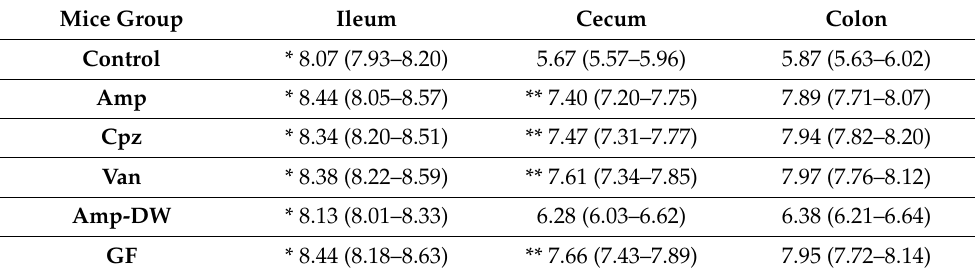
Figure 3. Gastrointestinal tract of the mice in various conditions. ( A ) Mouse treated for 1 week with ampicillin (Amp). ( B ) Mouse switched back to distilled water (DW) for 1 week after ampicillin treatment. ( C ) Germ-free mouse (GF). Table 2. pH values in different parts of mouse guts with antibiotic treatment, shown as the median (minimum value − maximum value). Since purified water (approximately pH 7) was added to the contents, the real pH was higher for alkaline pH values and lower for acidic pH values. In all groups tested, pH values were significantly different ( p < 0.05) between ileum vs. cecum, ileum vs. colon and cecum vs. colon (only Amp/Cpz/Van/GF